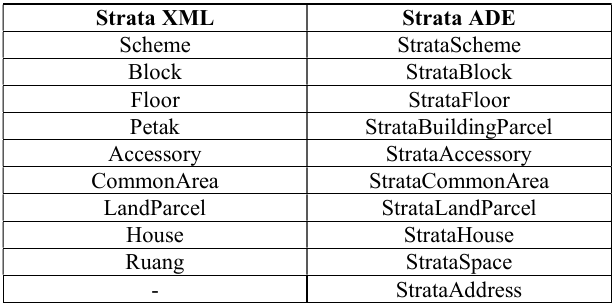
Table 1 . The mapping of StrataXML element with Strata